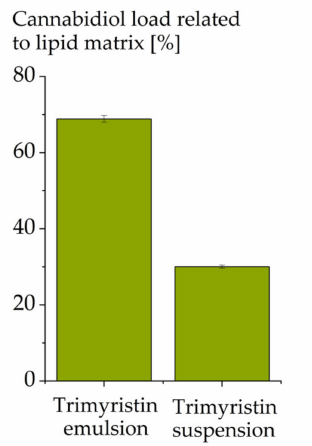
Figure 5. Cannabidiol load (mass percent) in a trimyristin emulsion and suspension of equal compo- sition (from TM-P188-120